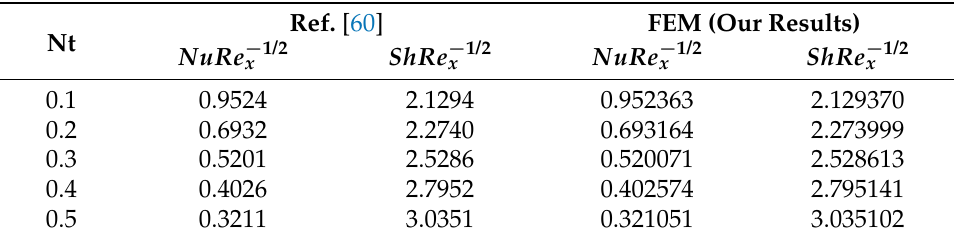
Table 4. Comparison of NuRe − 1/2 x , and ShRe − 1/2 x for specific values of Nt , when Nb = 0.1, Pr = 10.0, Le = 1.0, and not considering other involved